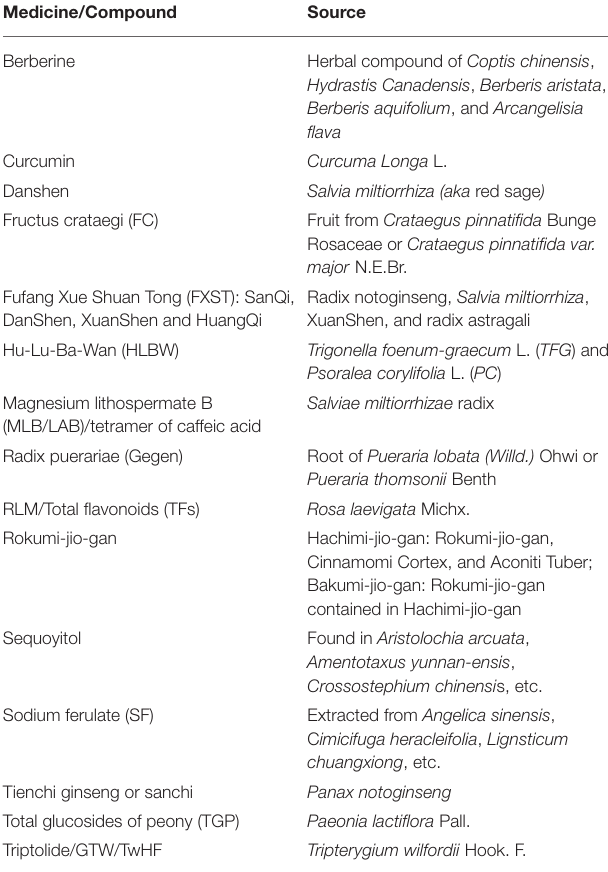
TABLE 2 | Traditional Chinese medicines with anti-oxidant and renoprotective